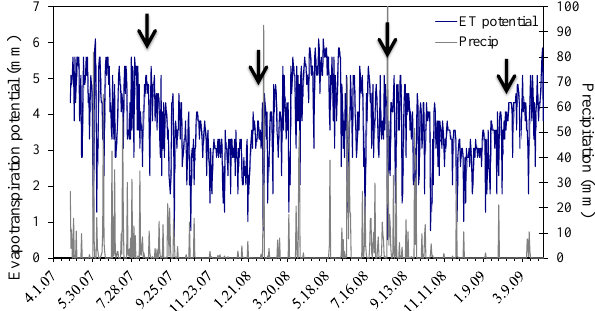
Fig. 3. Potential evapotranspiration (ET) and precipitation in tree island 3AS3. Recorded from High Head (HH)